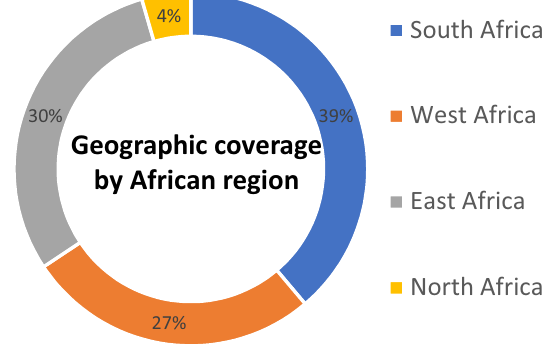
Fig. 1 Geographic coverage of studies by African